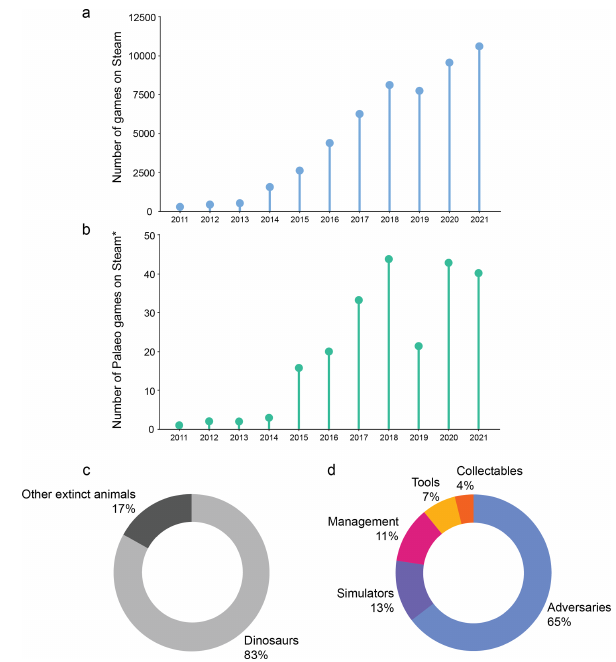
Figure 2. (a) Number of PC games released per year on Steam, the largest video game digital distribution service. (b) Number of games released per year that utilise palaeontological keyword “tags” on Steam. (c) Percentage of palaeontological COTS video games on Steam that contain dinosaurs versus those that only contain non-dinosaurian ancient animals (excluding crown group